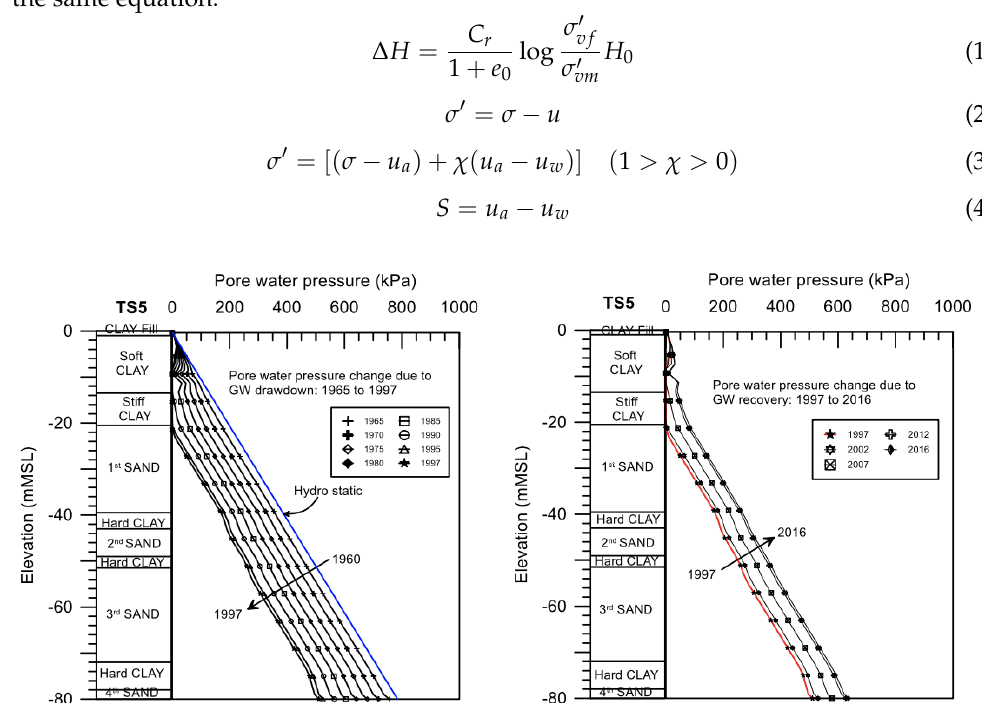
Figure 3. Pore-water pressure changes at SBTA